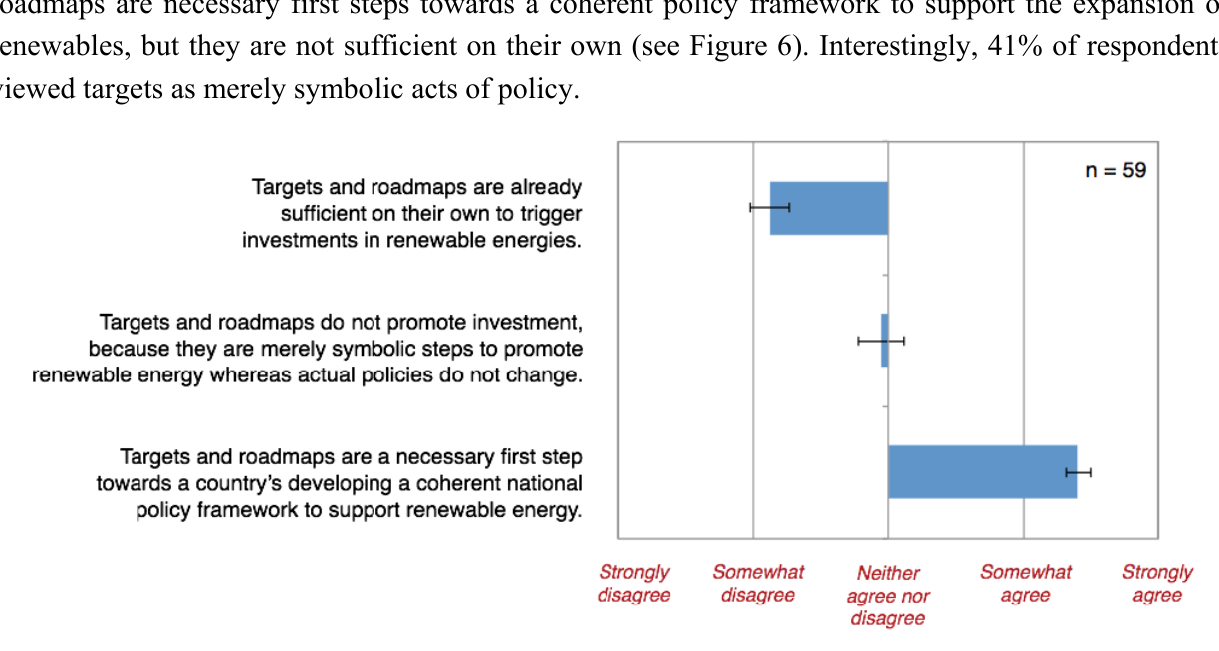
Figure 6. Results of question 5—targets and